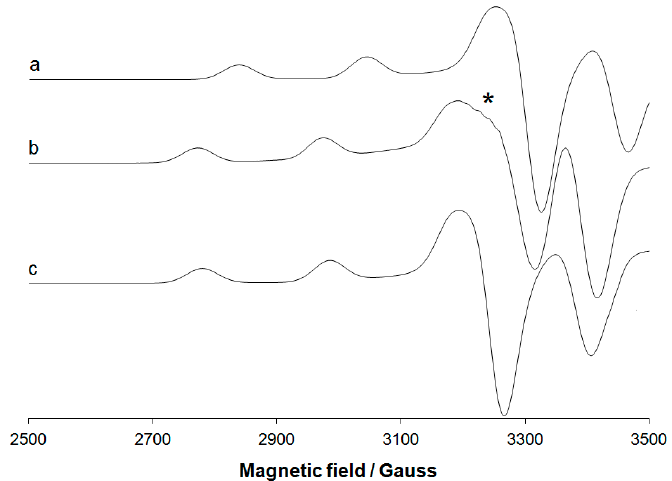
Figure 4. EPR spectra of the system Cu(II)/HSA: ( a ) spectrum generated using the spin Hamiltonian parameters calculated by DFT methods and reported in Table 4; ( b ) experimental spectrum and ( c ) spectrum generated using A calculated by DFT methods and g exp tl z . With the asterisk the superhyperfine coupling between the unpaired electron and 14 N nuclei (not generated with WinEPR SimFonia software [90]) is shown.